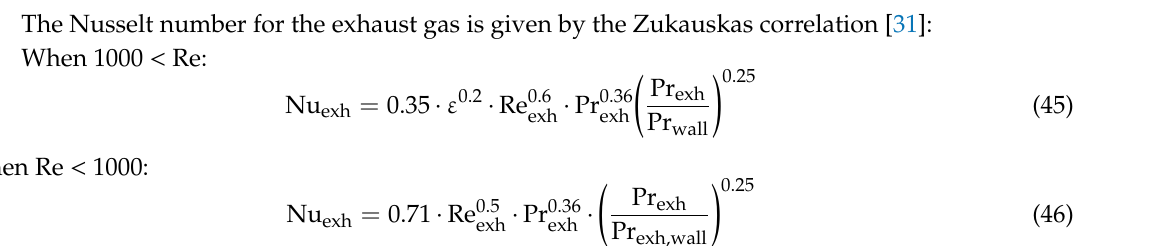
Figure 4. Schematic view of the fin-and-tube heat exchanger.